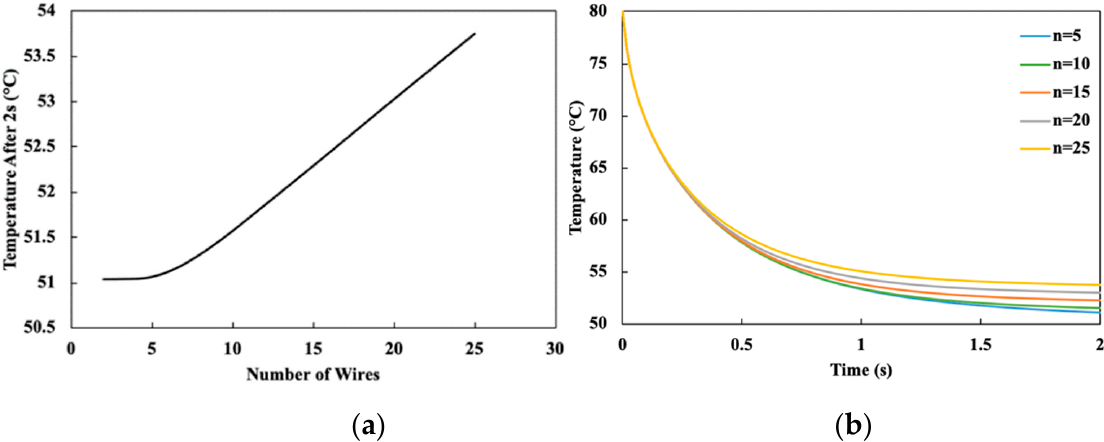
Figure 5. Results of transient thermal analysis for varying number of wires. ( a ) Maximum temperature distribution for varying numbers of wires after 2 s; ( b ) Selected transient maximum temperature distributions for varying numbers of wires.